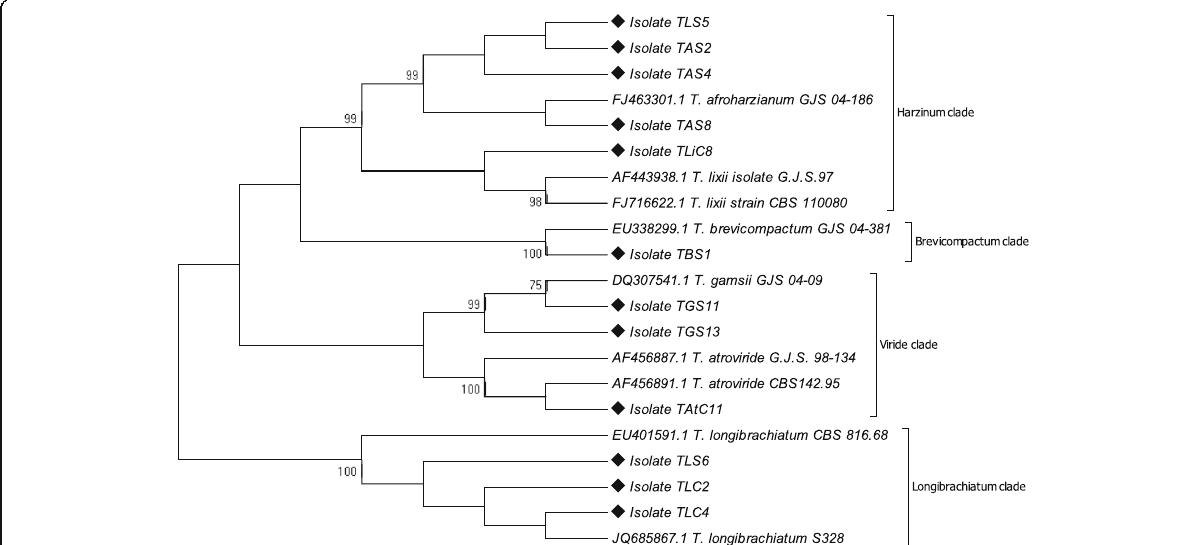
Fig. 2 Neighbor-joining phylogenetic tree of Trichoderma spp. constructed with tef1 sequences. Bootstrap support values higher than 75% from 1000 replicates are indicated on relevant tree branches